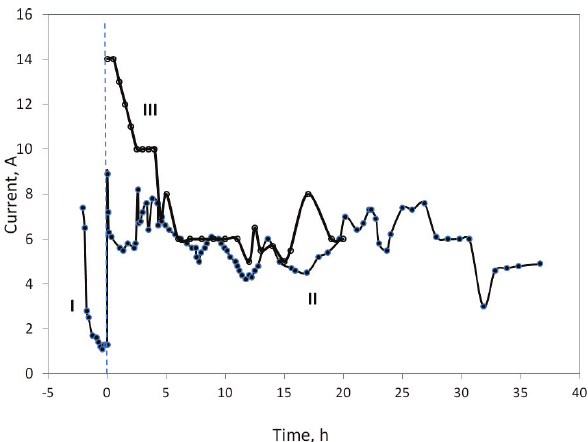
Figure 2. Current versus time plot for pre-electrolysis (I), electrolysis for 39 h (II) and electrolysis for 19h (III) of pellet in molten CaCl at 950°C. Cell voltage for pre- TiO 2 2 electrolysis: 2 V.